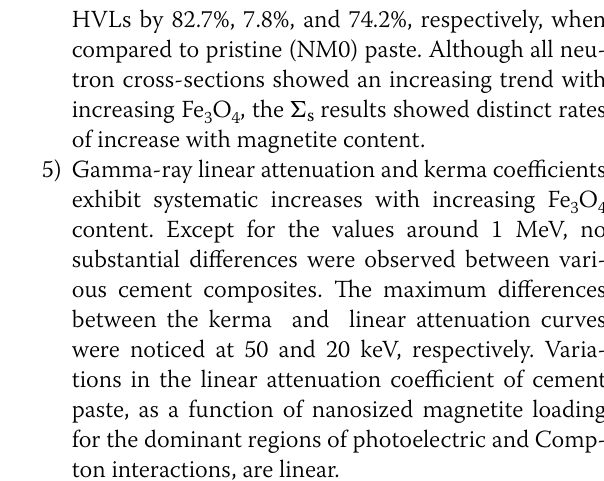
Fig. 15 The normalized kerma coefficient values, with respect to the control